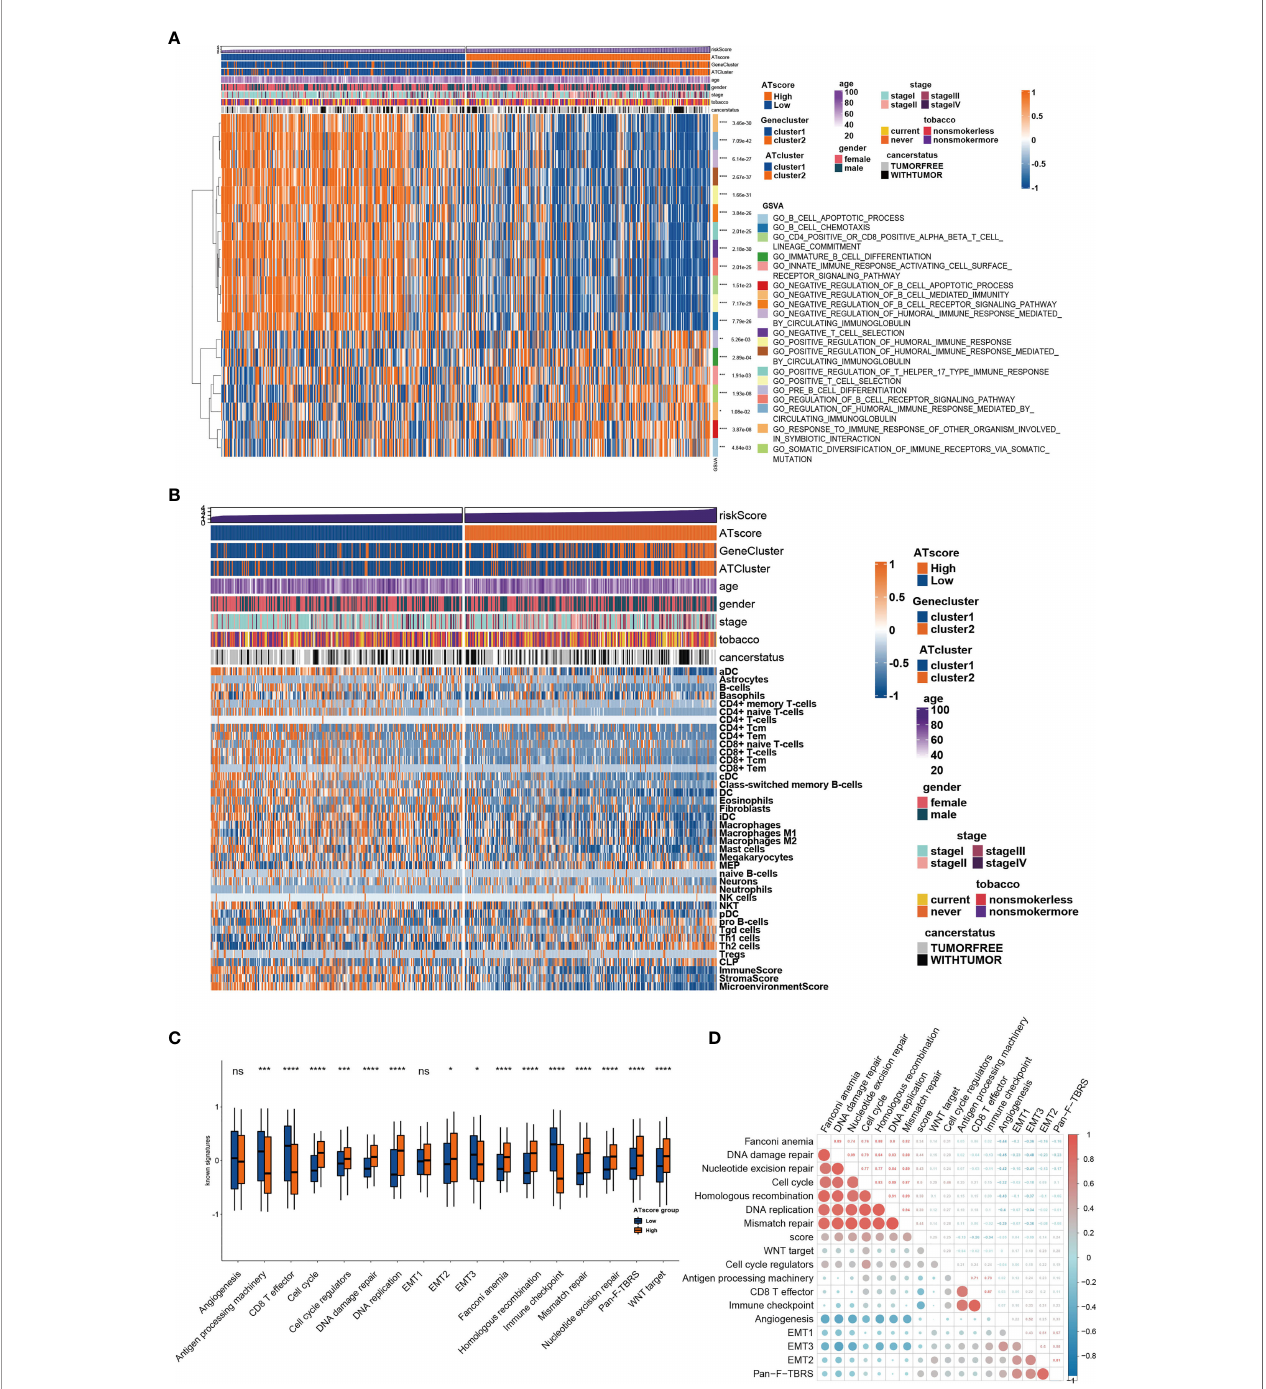
FIGURE 5 | The transcriptome features of patients with various ATscores in TCGA cohort. The GSVA analysis showed the different immune-related patterns of patients with various ATscores in TCGA cohort (A) . The diversity of immune cells in fi ltrating patterns between patients with various ATscores was identi fi ed by xCell algorithm, and our results showed a more speci fi c correlation of ATscores with checkpoints therapies-related immune cells (B) . Patients with various ATscores also presented different states of well-known signaturesand carcinogenesis pathways (C, D) . *P<0.05, **P<0.01, ***P<0.001, ****P<0.0001. “ ns ” means no signi fi